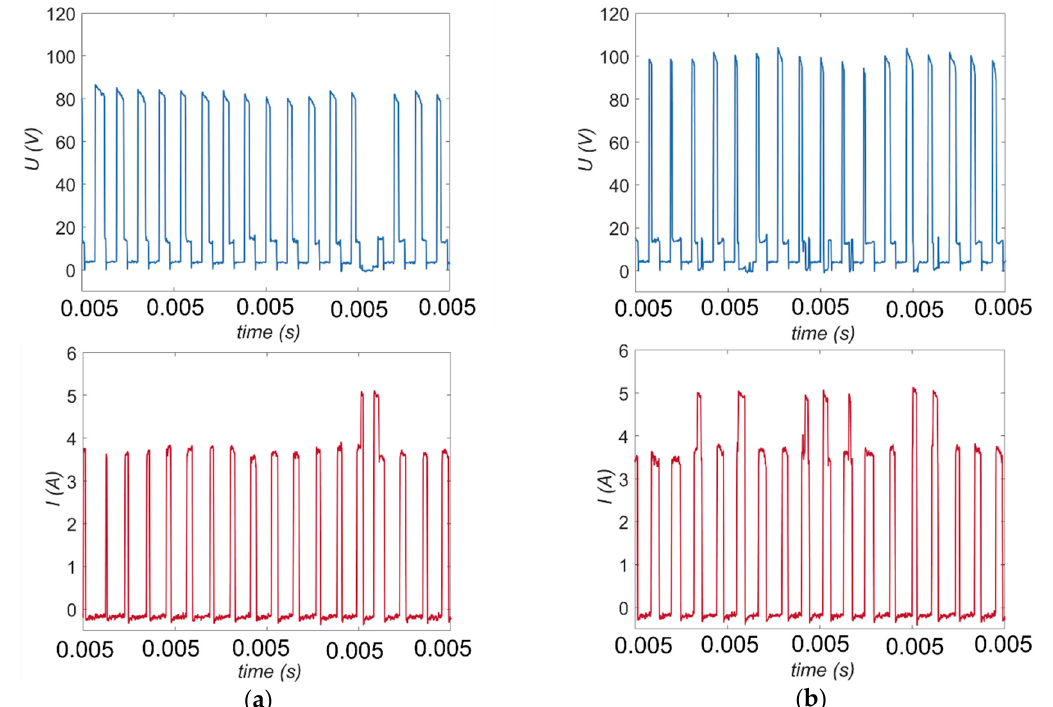
Figure 10. The recorded voltage and current waveforms for the applying open voltage: ( a ) U = 100 V; and ( b ) U = 120 V; t on = 550 µs, I = 3.33 A, p = 7 MPa, n = 300 rpm.